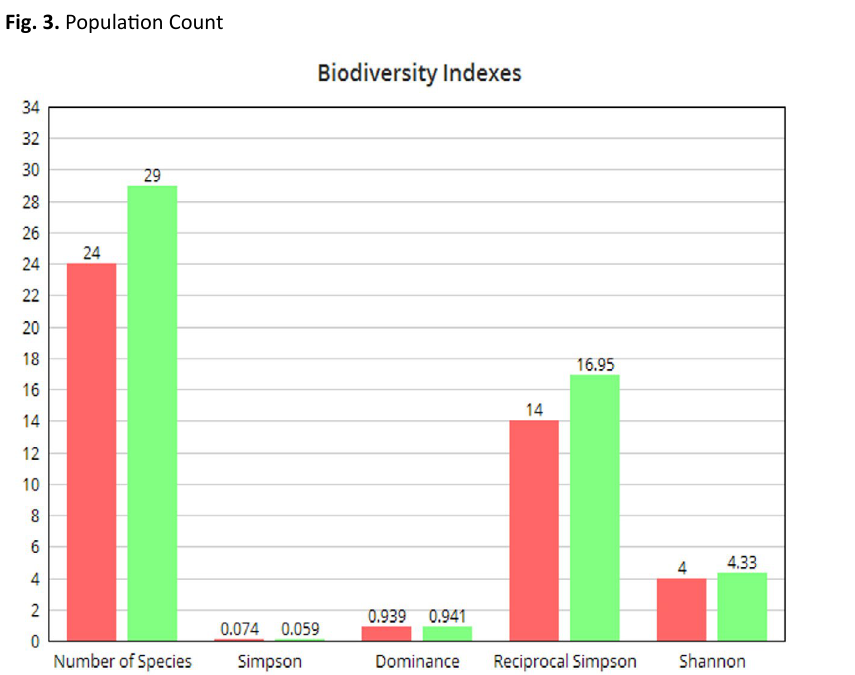
Fig. 3. Population Count